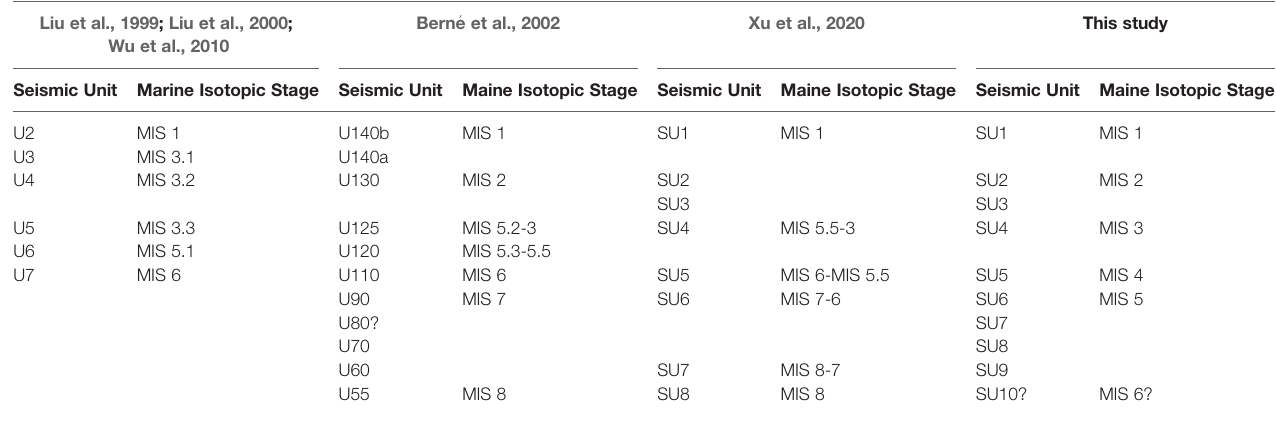
TABLE 3 | Comparison in the interpretation of seismic stratigraphy on the ECS outer shelf between previous studies and this work. Liu et al., 1999; Liu et al., 2000; Berne ́ et al., Wu et al., 2010